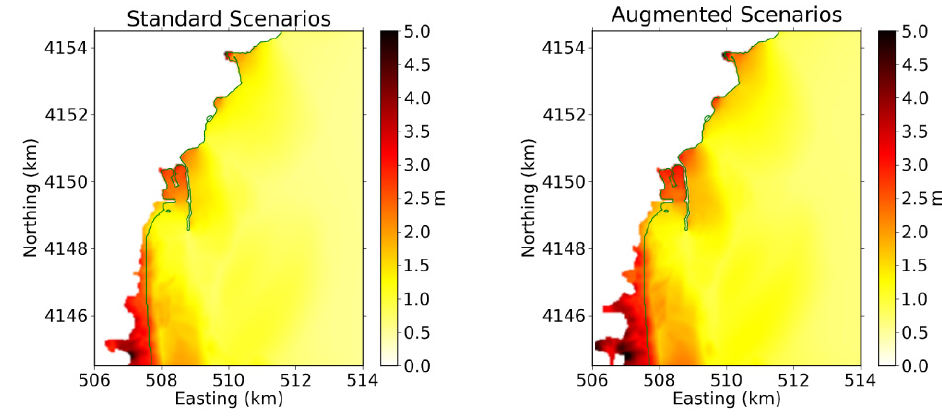
Fig. 13. Maximum water elevation for both the aggregate standard (left) and augmented (right) scenario.